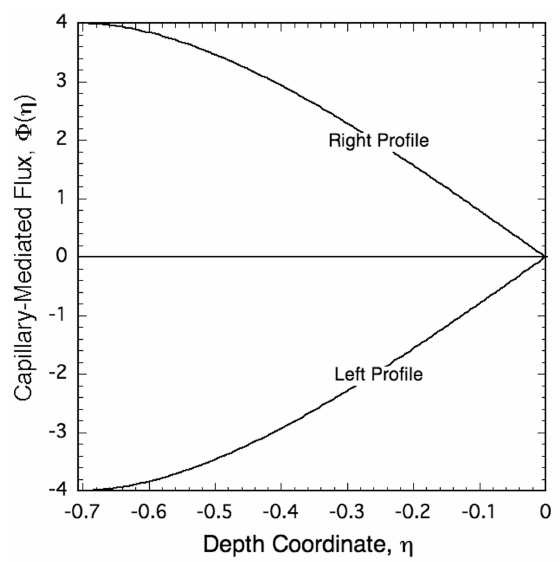
Figure 3. Plot of the magnitudes of the capillary-mediated dimensionless fluxes, ˆ Φ τ ( η ( µ )) , along the left and right profiles of a grain boundary groove with zero dihedral angle. The directions of the µ -components of these fluxes oppose each other. Left and right thermal flux vectors rotate clockwise and anti-clockwise, respectively, as they descend into the steeper portion of the cusp. These components become parallel as the triple junction is approached, where their η -components combine and enter the grain boundary with a flux magnitude of